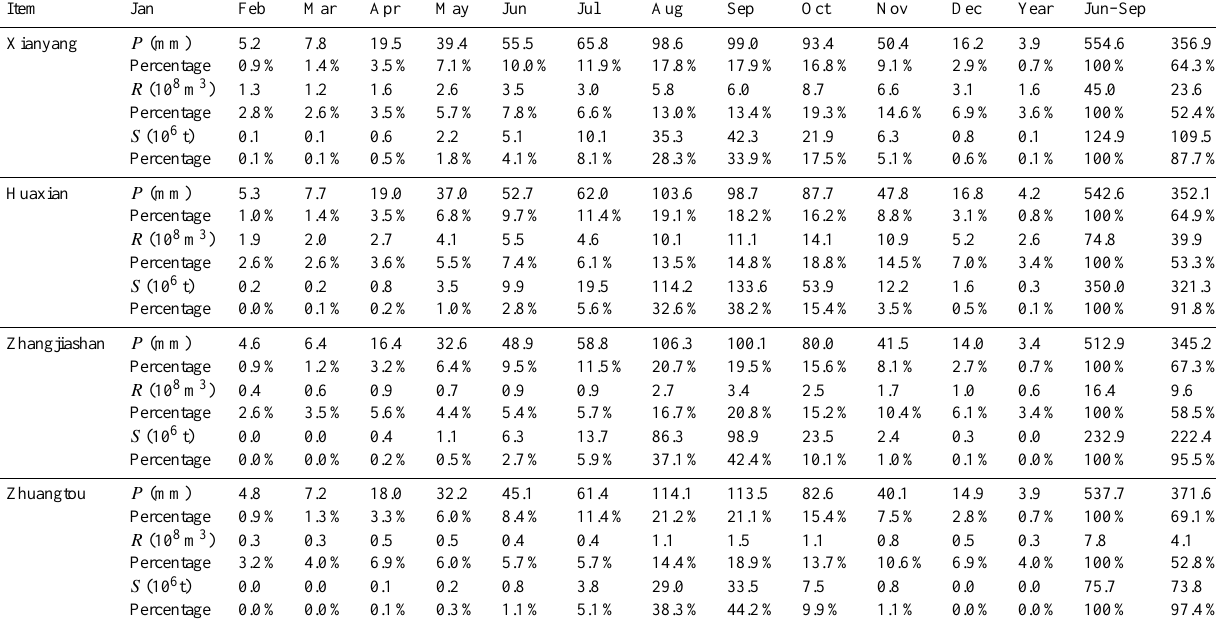
Table 3. Distribution of monthly precipitation, stream flow and sediment in the Wei River basin ( P =mean precipitation, R =mean stream flow, S =mean sediment